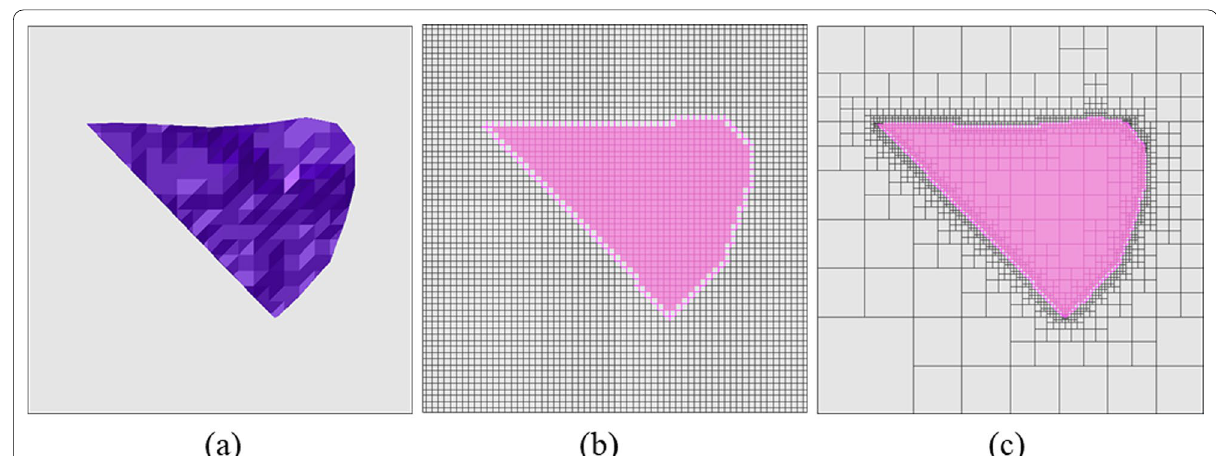
Fig. 5 An example of a hierarchical mesh for a domain having an object with irregular geometry. The fictitious fan‑shaped object is shown in a , and two different meshes are shown in b and c . The minimum cell sizes in b and c are 2 m and 1 m, corresponding to the total numbers of cells as 250,810 and 201,612,